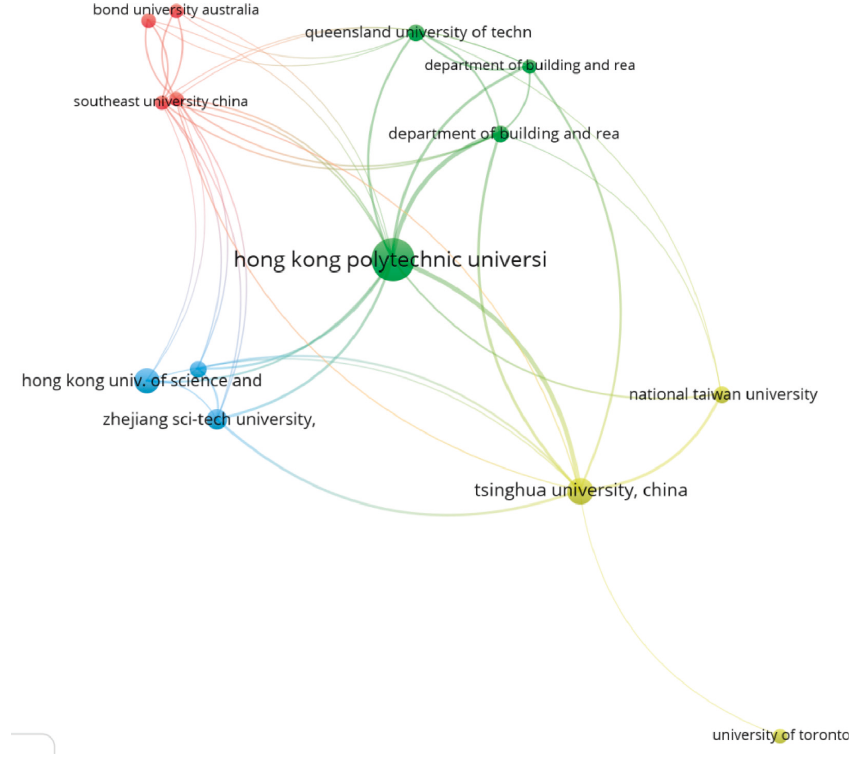
Figure 7: Mapping of organizations active in PPP research.